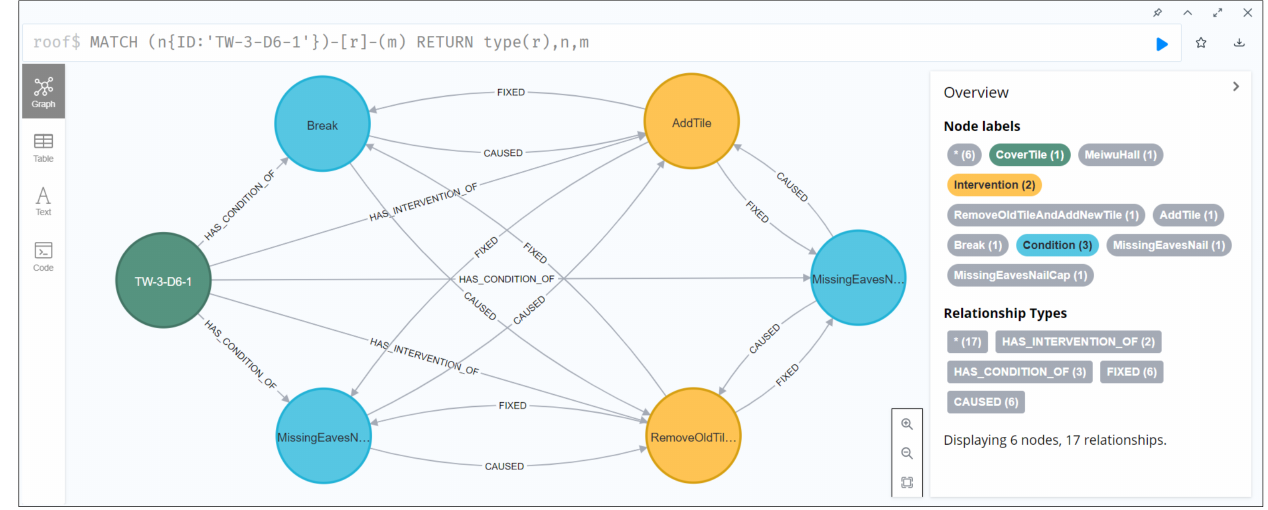
Figure 13. An example of a query in the graph